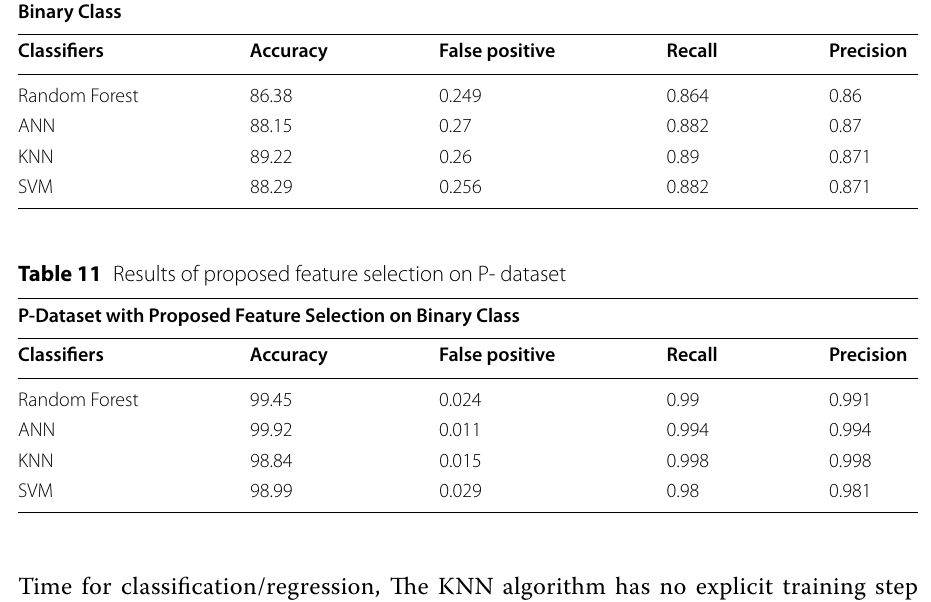
Table 10 Results on P-dataset without feature selection algorithm P‑Dataset Without Feature Selection